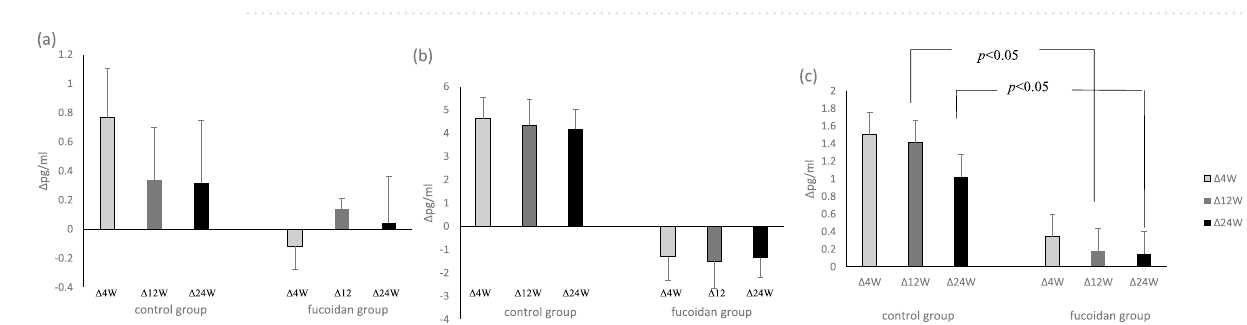
Figure 2. The concentrations of cytokines ( a ) IL-1β , ( b ) IL-4, ( c ) IL-6,( d ) IL-8, ( e ) IL-17α, ( f ) IFNγ in the two groups during supplementation period.